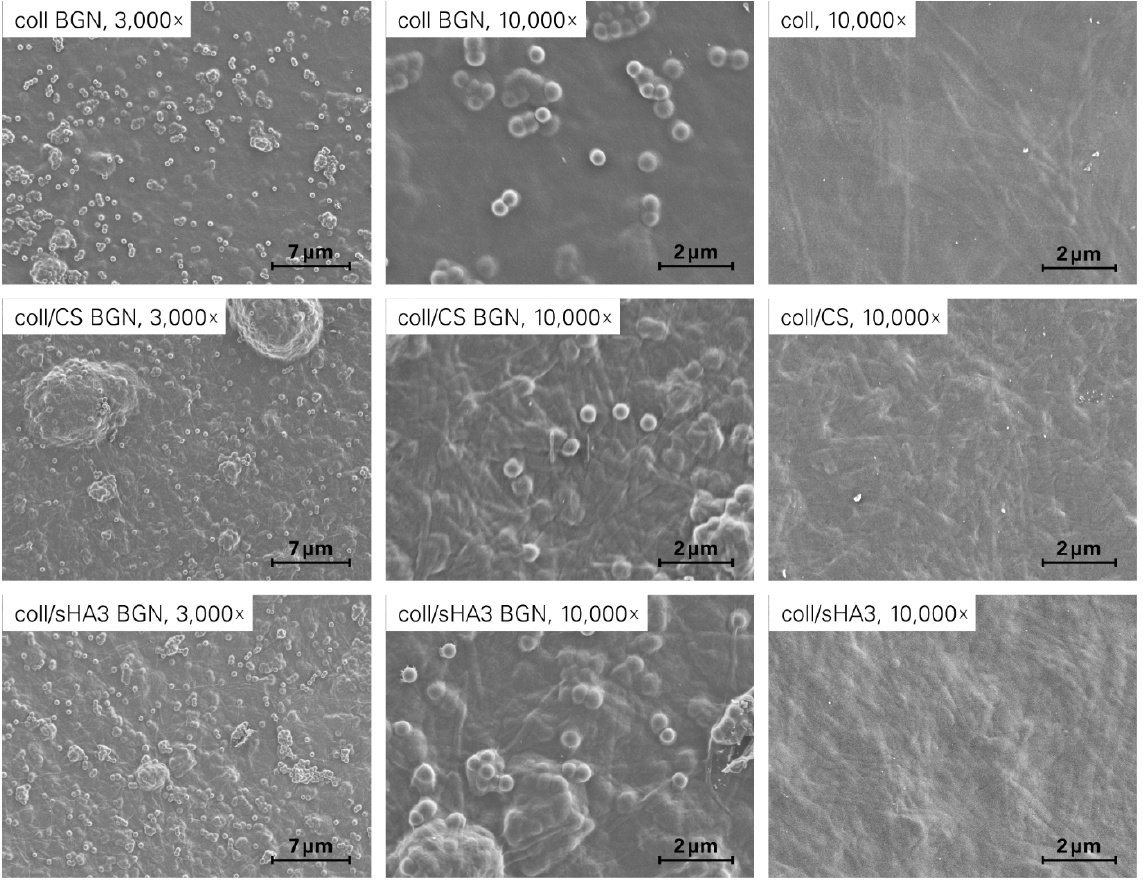
Figure 3. SEM micrographs of different aECM. Micrographs were taken from the initial state of different aECM coatings at 3000× and 10,000× magnification.